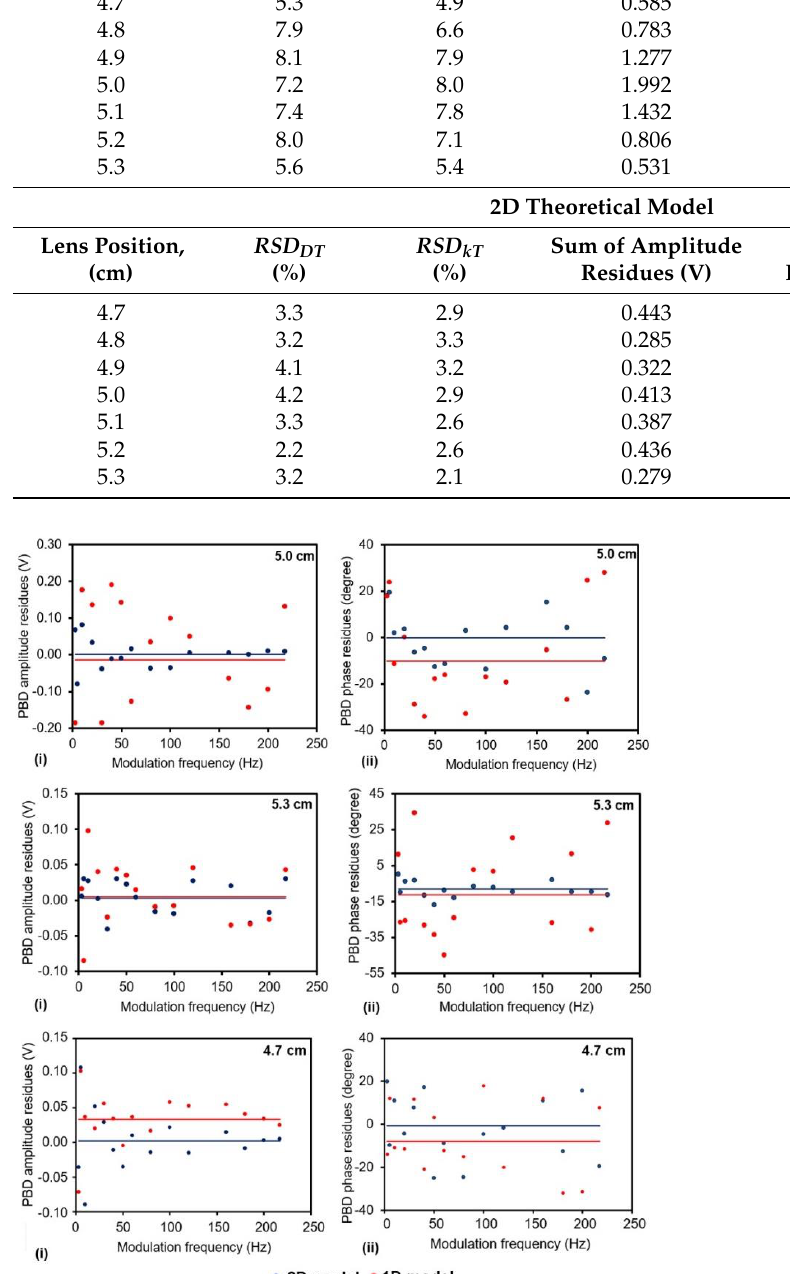
Table 4. Values of RSD and sum of residues for thermal diffusivity D T and conductivity k T determi- nation in case of the 1D theoretical model and 2D theoretical model. Table 3. Values of PuB radii for different positions of forming lens and ratio of PuB/PrB radii. Lens Position, cm